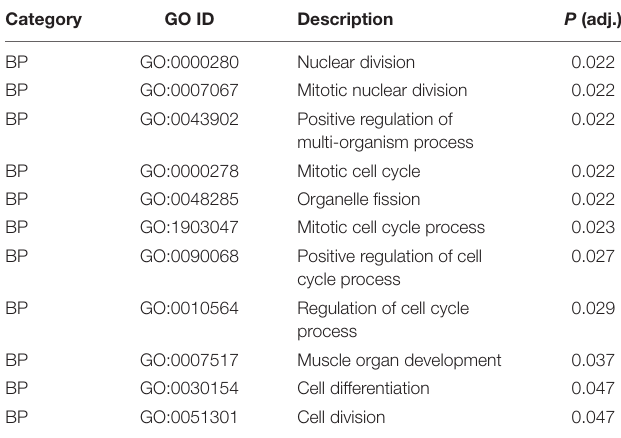
TABLE 3 | Significant enrichment in GO